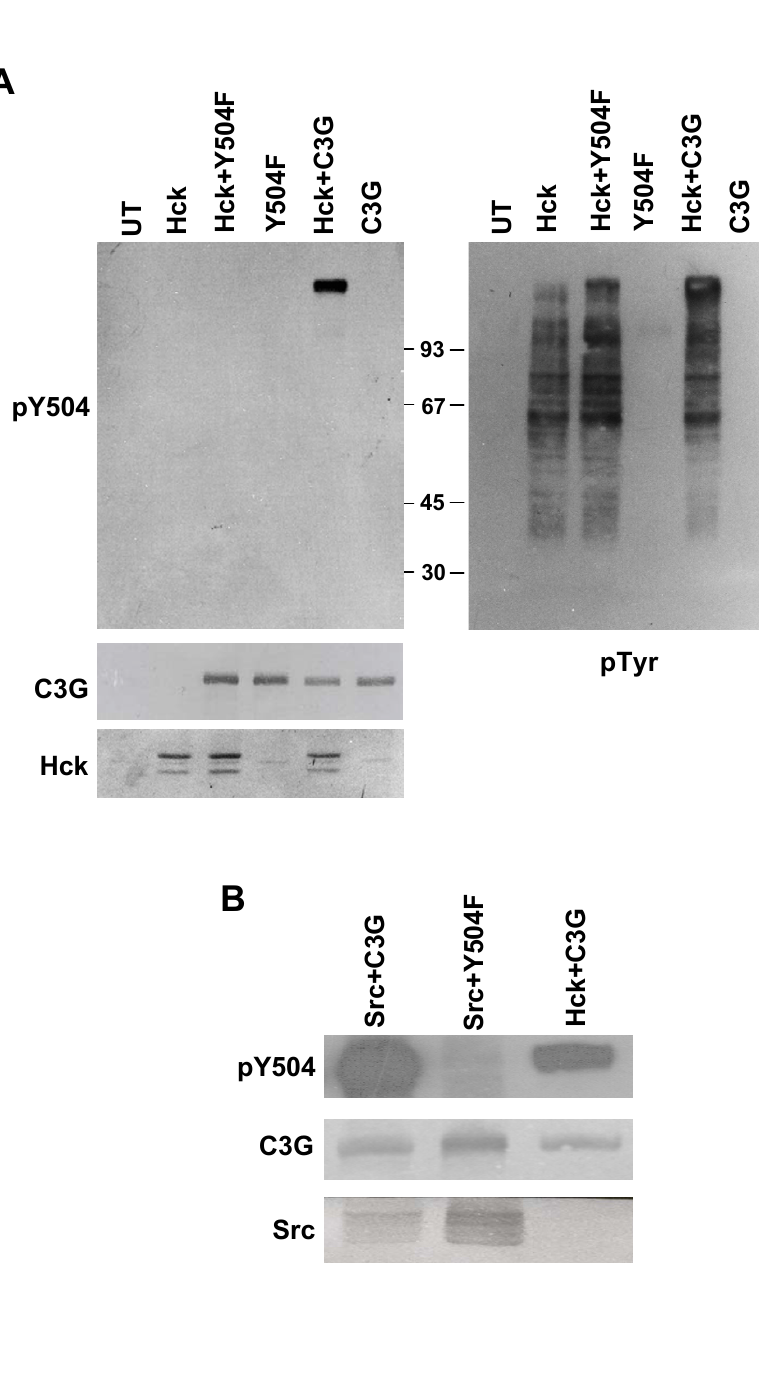
Figure 2 Specificity of phosphospecific antibody, and phosphorylation of C3G on Y504 upon coexpression with Src fam- ily kinases. Cos-1 cells were transfected with the expression constructs for Hck (A) or c-Src (B) along with C3G as indicated and western blotting of whole cell lysates was performed using the phosphospecific antibody pY504. The blots were reprobed with C3G, Hck and anti pTyr (Panel A) or Src (Panel B) to show their expression in the lysates. pY504 C3G and pTyr was detected by ECL and C3G, Hck and Src by alkaline phosphatase dependent color development. UT indicates untransfected cell lysates. Y504F is a mutant of C3G in which tyrosine 504 is replaced by